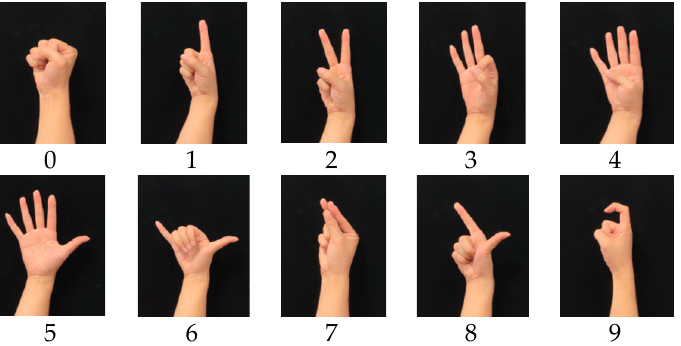
Figure 19. Digital gestures for 0 to 9.